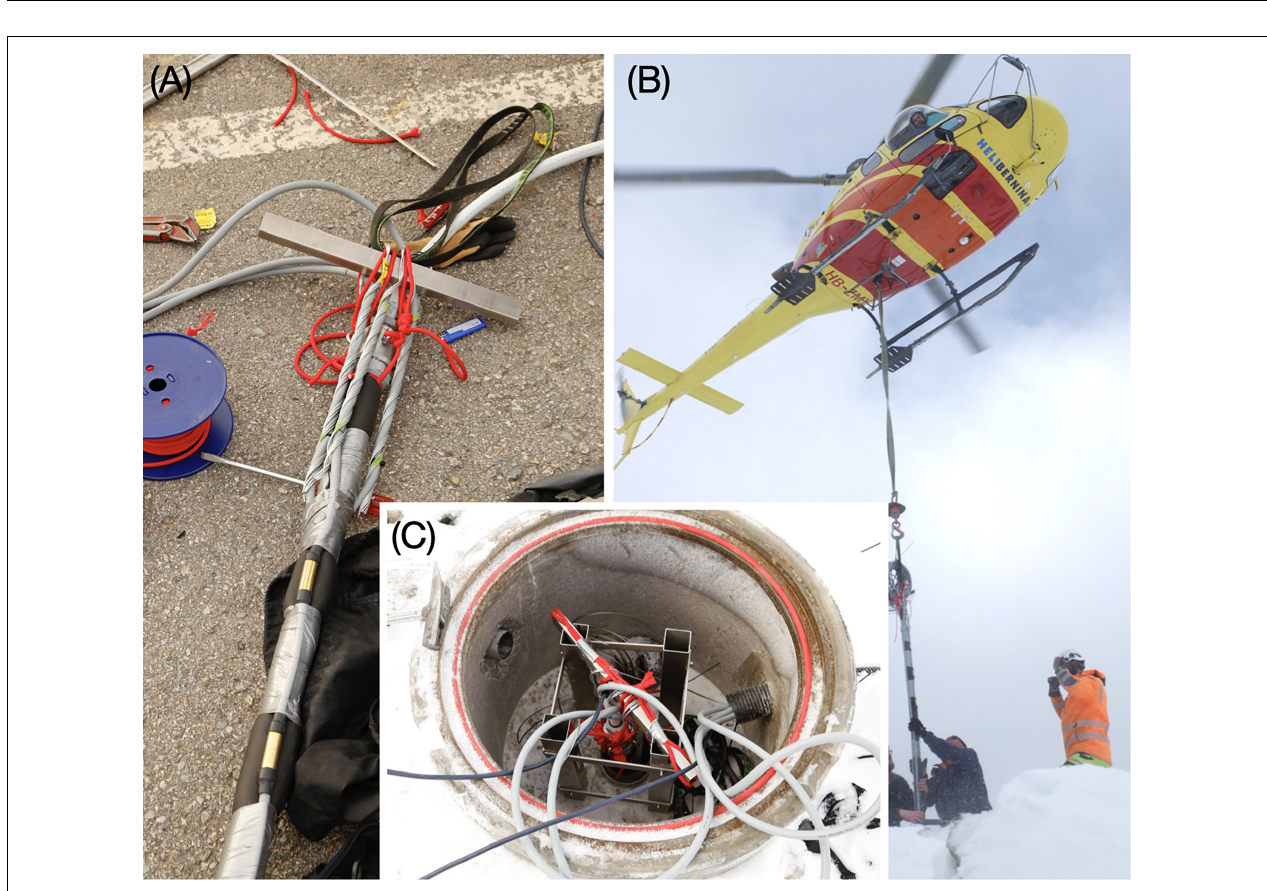
FIGURE 8 | Installation of the sensor instruments into the borehole at Murtèl-Corvatsch in September 2015. Relative assembling of the three temperature sensor strings and the SAAF device ( A , photo: A. Bast), installation in the borehole with a helicopter ( B , photo: D. Wasser), and suspension device ( C , photo: A. Bast).